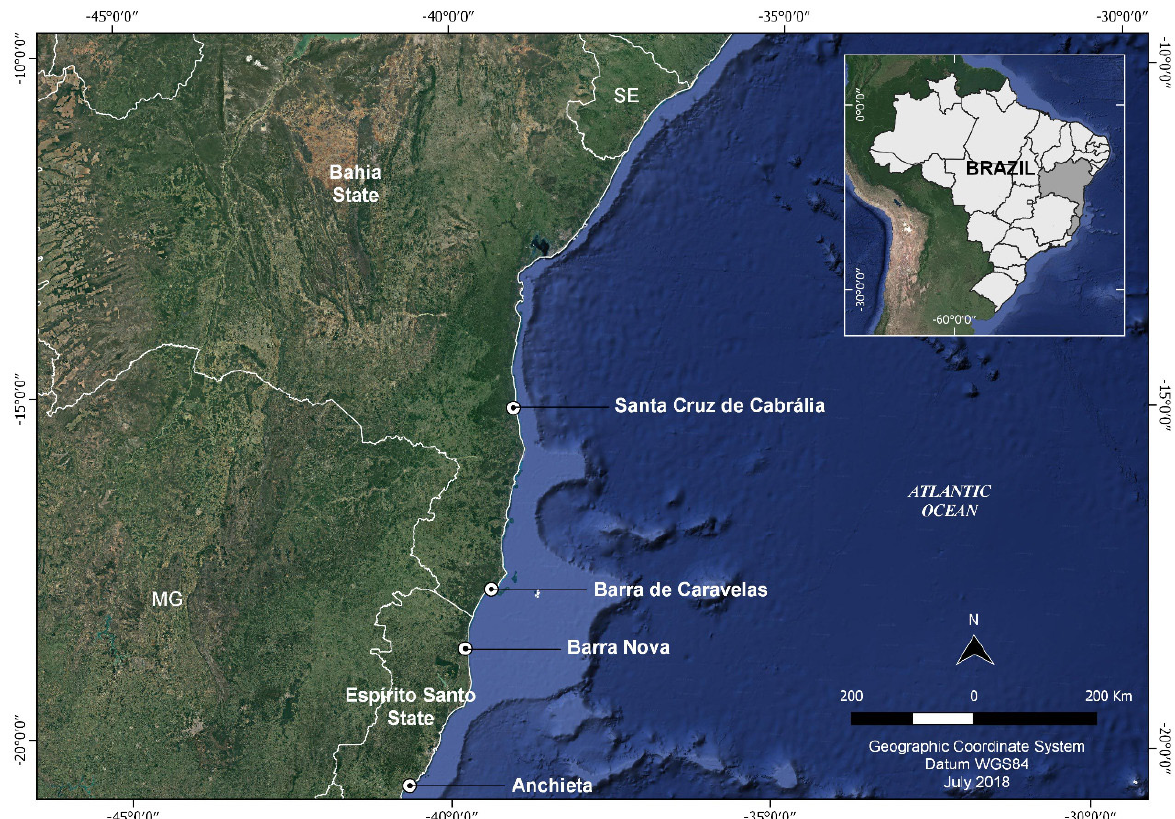
Figure 1. Map of the study area, highlighting the studied communities along the central Brazilian